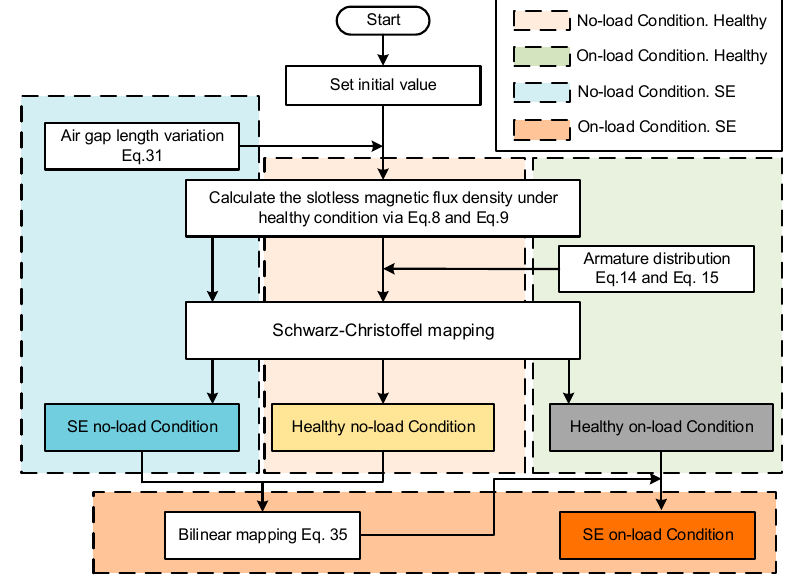
Figure 7. Calculation processes of magnet flux density.